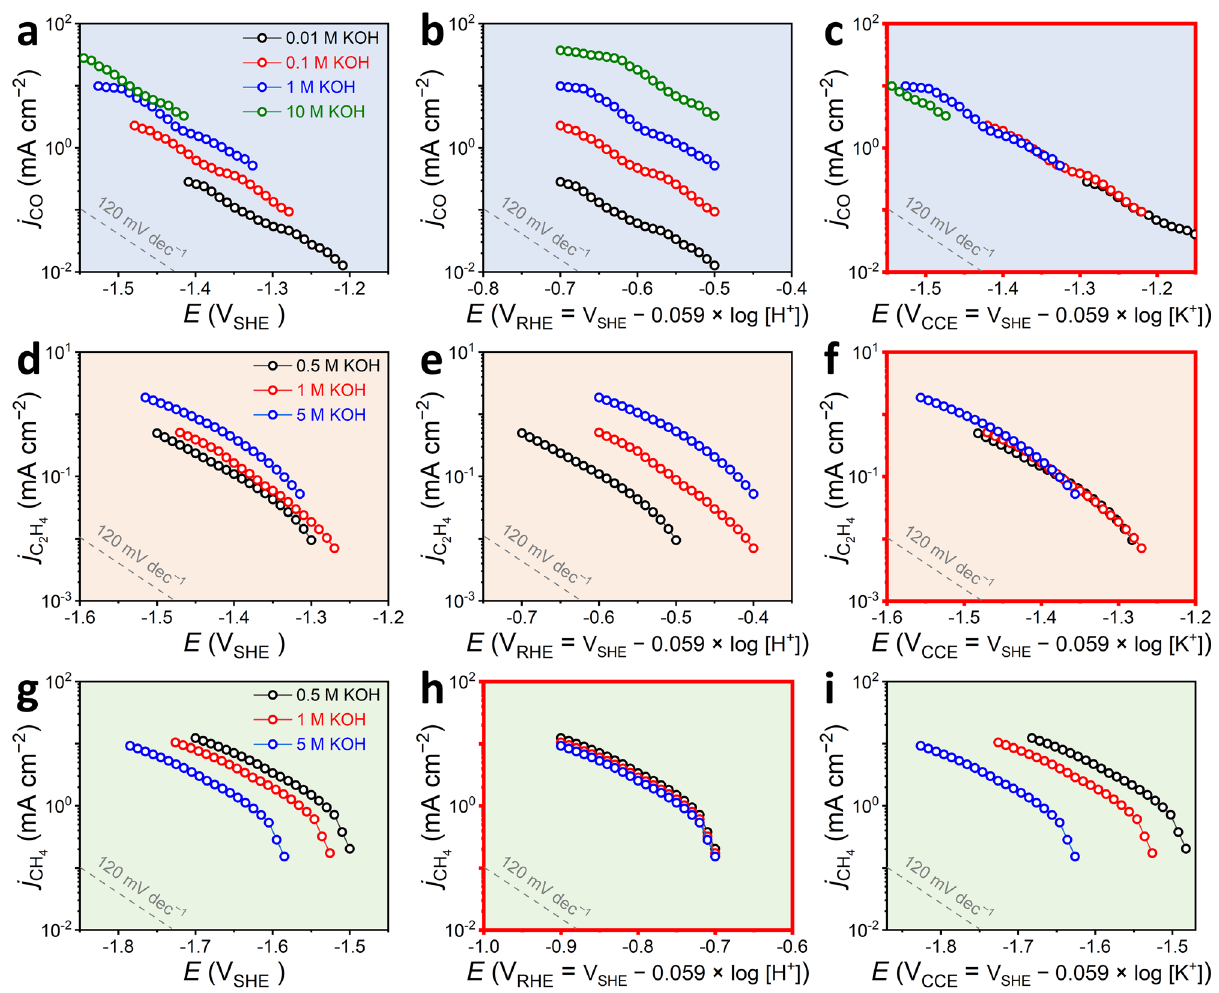
Fig. 3 | Electrochemical CO 2 RR and CORR in various electrolytes. a – c The CO 2 - to-CO conversion was measured on the Ag electrode in 0.01 – 10M KOH electro- lytes. d – f The CO-to-C 2 H 4 and g – i the CO-to-CH 4 conversions were measured on the Cu electrode in 0.05 – 5M KOH electrolytes. All the electrolysis measurements wereperformedinanelectrochemical fl owcell.Thepolarizationcurvesareplotted with respect to the a , d , g SHE, b , e , h RHE (V SHE – 0.059×log[H + ]), or c , f , i , CCE